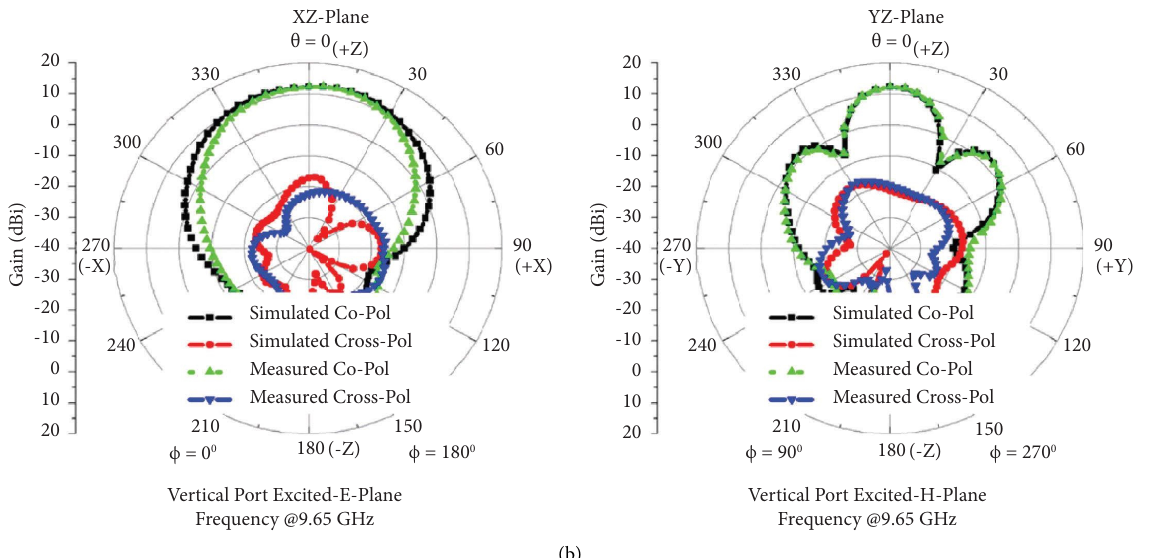
Figure 13: (a) Simulated and measured radiation pattern of port-3 excited phi � 0 ° -plane @9.65 GHz and port-3 excited phi � 90 °